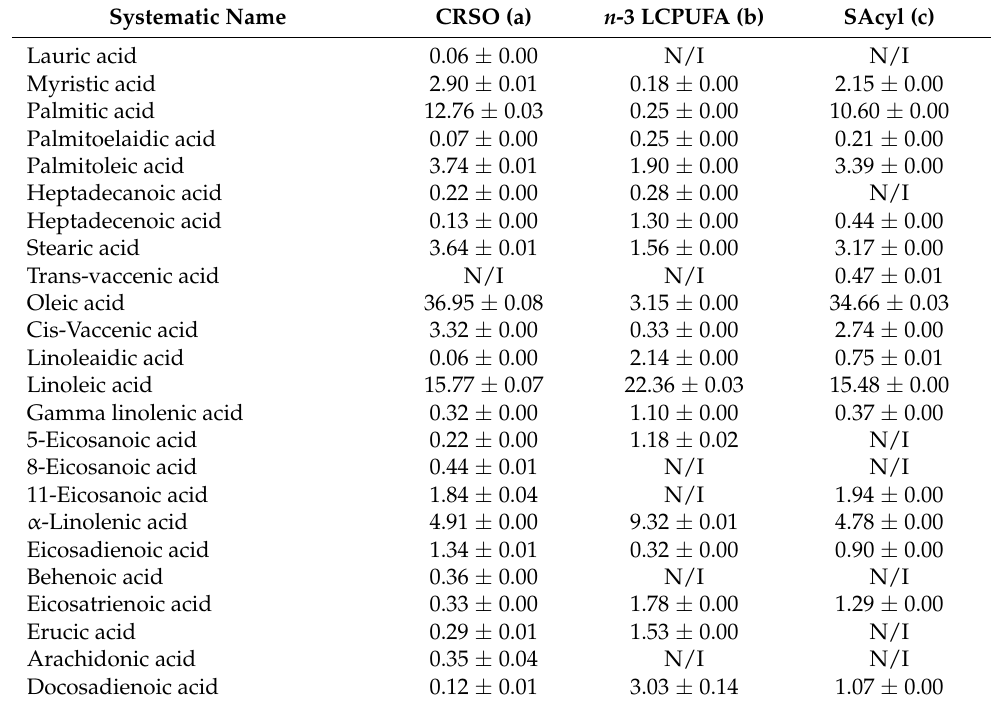
Table 3. Composition and quantification * of fatty acids from: (a) commercial refined salmon oil (CRSO), (b) concentrate of long-chain polyunsaturated fatty acids n -3 ( n -3 LCPUFA), and (c) optimally structured acylglycerols with EPA/DHA in sn -2 (SAcyl), (calculated as g/100 g